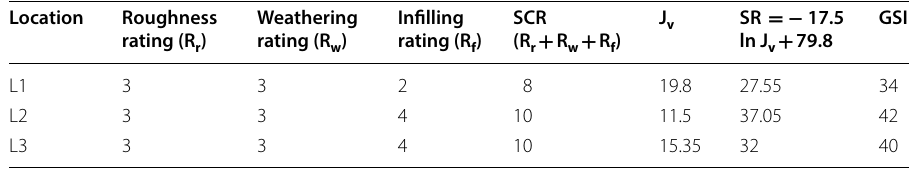
Table 3 Different parameters used for the estimation of GSI